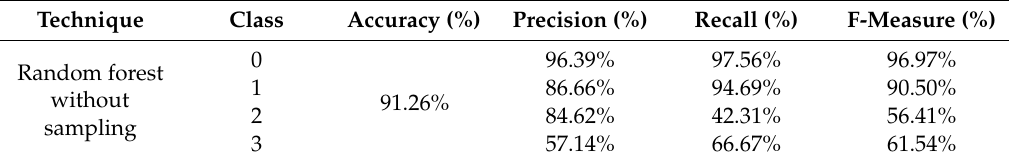
Table 5. Performance of prediction without using imbalanced